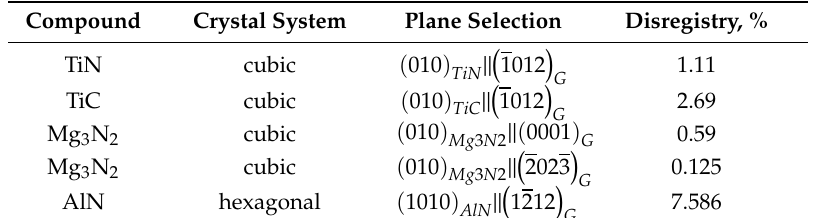
Table 5. Calculated planar disregistry between graphite and various compounds.